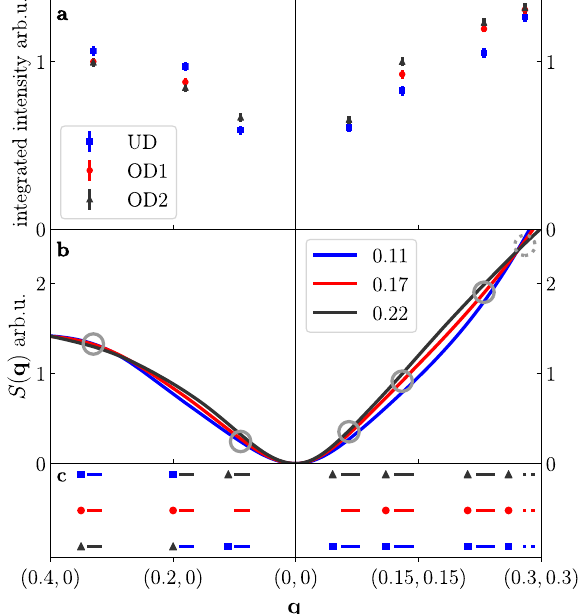
Fig. 5 Comparison between the static spin structure factor in experiment and theory. a The experimental proxy for the static spin structure factor, i.e. the integrated intensity of the spin excitations as seen by RIXS on Bi2212, see Fig. 3 h . The points are normalized to the value of the intensity at q = (0.13, 0.13) for the OD2 doping level. The error bars represent the integration errors assuming that the spectral errors have an energy correlation de fi ned by the resolution function (see Methods). b Static spin structure factor S ( q ) obtained using DMRG on a 6 × 6 cluster (see text for further details) for the t - t 0 - t 00 - J model and three different hole-doping levels. The results are normalized to the value of S ( q ) at q ≃ (0.13, 0.13) for the doping level n = 0.22. Model parameters: J = 0.4 t , t 0 ¼ (cid:1) 0 : 3 t , t 00 = 0.15 t . c Schematic comparison between the face-value of the experi- mental and numerical sequences of intensities: points refer to RIXS experiments and lines to the DMRG numerical results. The sequence at q = (0.28, 0.28) momentum refer to the sequence seen in the numerical results at q = (0.267, 0.267), see text for further details. Only q = (0.18, 0) momentum cannot be reproduced by our theoretical calculations. intensity at the Brillouin zone center q = (0, 0), making it gap-like, which is not found in the numerical results. The reason for this apparent disagreement is likely the inter-layer interaction in this bilayer cuprate, which gives rise to the onset of the optical and acoustic magnon branches 7,34,53,54 . While the 2D antiferromag- netic acoustic spin wave has a zero structure factor at the zone center [ q = (0, 0)], the optical branch due to the inter-layer coupling will show a non-zero intensity, thus leading to a ‘ gap ’ in the zone center. As our calculations do not include the coupling between the layers, this gap feature is absent. However, due to the inter-layer interaction being much smaller than the intra-layer one, the two branches quickly merge as q moves away from the zone center ( ≳ 0.1 r.l.u.) 7,53,54 , and their total intensities will be dominated by the intra-layer parameters. Therefore, the compar- ison between our calculations and the experiments is in reason- able agreement apart from the zone center. The agreement between the t - t 0 - t 00 - J model and experiments can be appreciated even more after looking at Fig. 6, where we present the comparison between the theoretical results of the three different t - J -like models. Fig. 6a shows S ( q ) calculated for the ‘ bare ’ t - J model. Within this model, the sequence of intensities of the spin structure factor as a function of doping does not change in the experimental momentum range, unlike the results of the experi- ments. Fig. 6b shows the same quantity as Fig. 6a, but for the t - t 0 - J